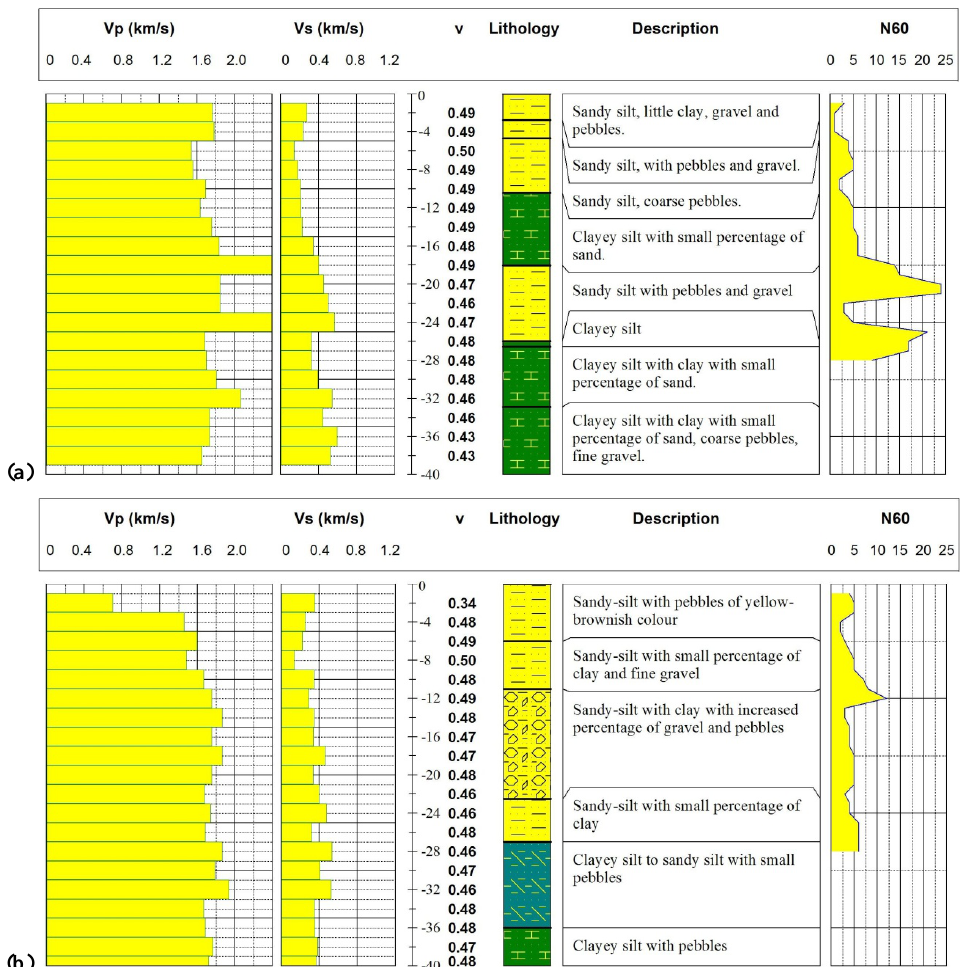
Fig. 6. (a) Examples records of the seismic survey at AA 0 and (b) EE 0 sites. (c) The phase velocity spectrum with frequency gives a clear picture about the dispersion curve.